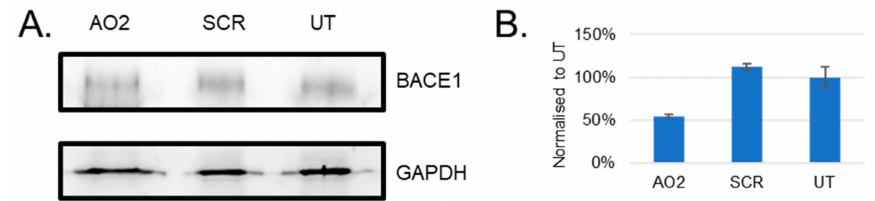
Figure 7. ( A ) Representative Western blot protein analysis of the BACE1 and GAPDH proteins after 24 h treatment with AO2 targeting exon 2 at 400 nM in HEK293 cells. FL, full-length; UT, untreated; SCR, scrambled sequence; GAPDH was used as a loading control. The gel images were cropped to highlight the BACE1 protein and the corresponding house-keeping protein control GAPDH. The original images are shown in Figure S7 (Supplementary Information). ( B ) Densitometry analysis of protein products showed downregulation of BACE1 protein in HEK293 cells in